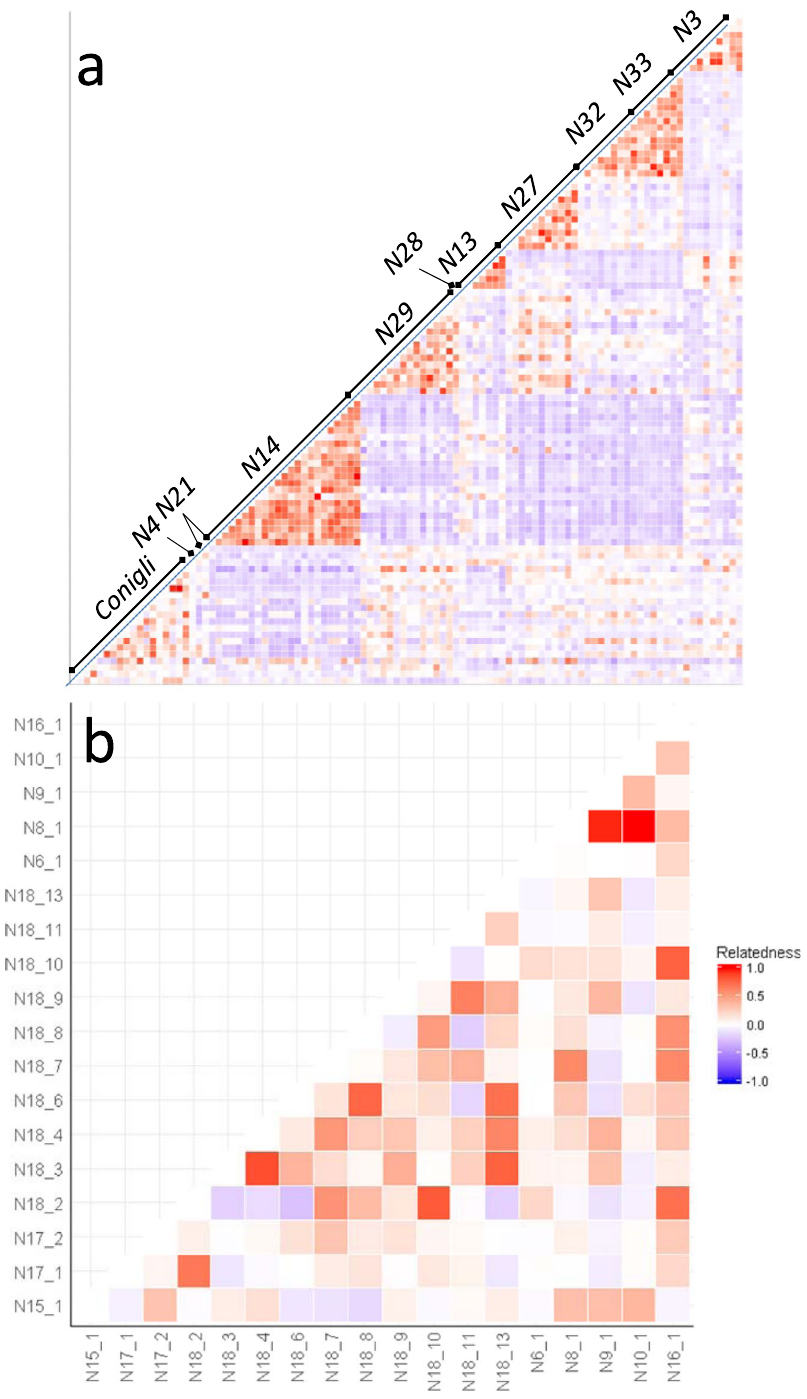
Figure 3. Heatmap of the relatedness index among sample pairs of the Mediterranean sporadic nests. Each cell represents the value of Lynch & Ritland relatedness index 91 among individual samples as plotted in both the y and x axis. Panel a) includes the values of all the possible sample pairs with the samples of each nest indicated in the diagonal. Panel b) includes the values of all the sample pairs of the nests laid in Conigli Beach